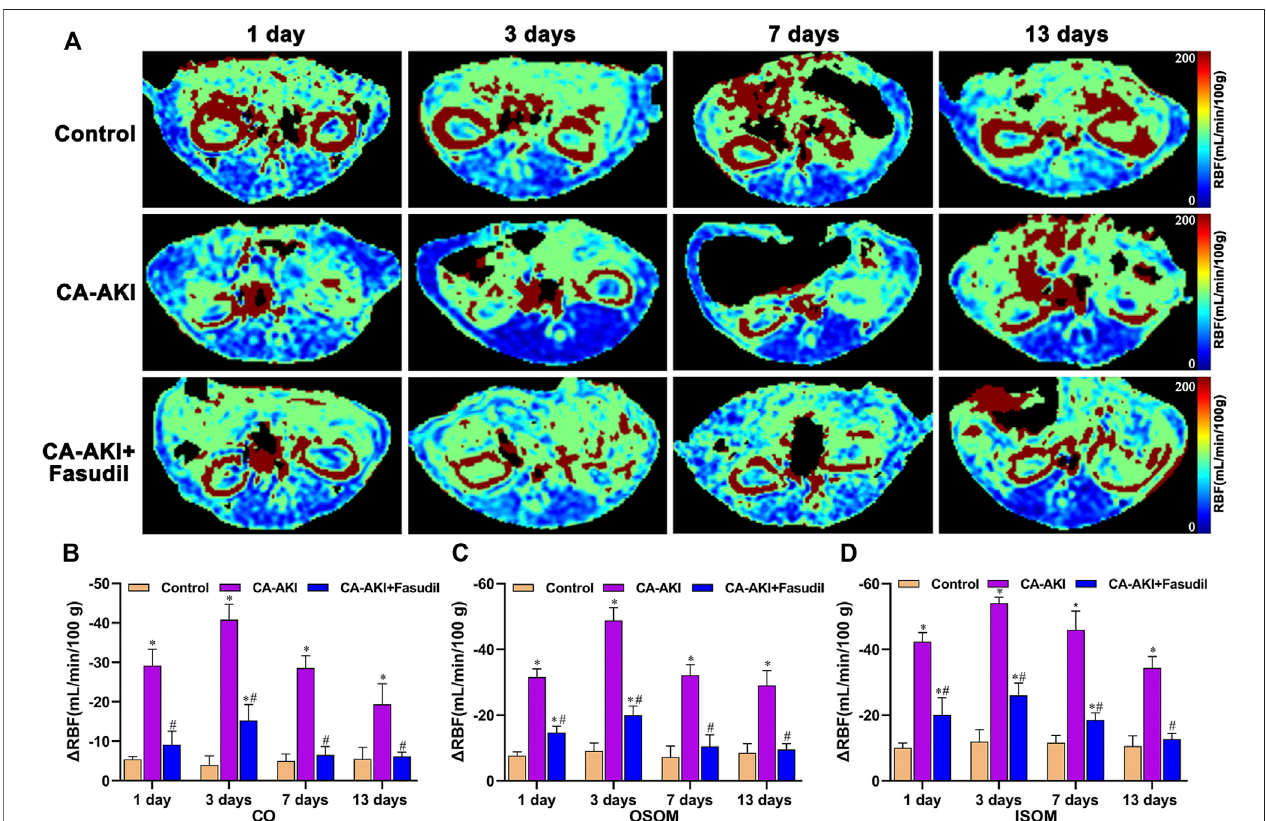
FIGURE 3 | Representative ASL maps in three animal groups: (A) Parametric images obtained from ASL maps and (B – D) quantitative analysis of Δ RBF values at CO,OSOM,andISOM.Thesamewindowlevel,andwidtharedisplayedforASLmaps.Signalchangesarescaledfrom0(blue)to200(red),representingarangeofRBF values. * p < 0.05 between CA-AKI/CA-AKI + Fasudil and controls; # p < 0.05 between CA-AKI + Fasudil and CA-AKI. ASL: arterial spin labeling; CA-AKI: contrast- associated acute kidney injury; RBF: renal blood fl ow; ISOM: inner stripe of the outer medulla; CO: cortex; OSOM: outer stripe of the outer medulla.